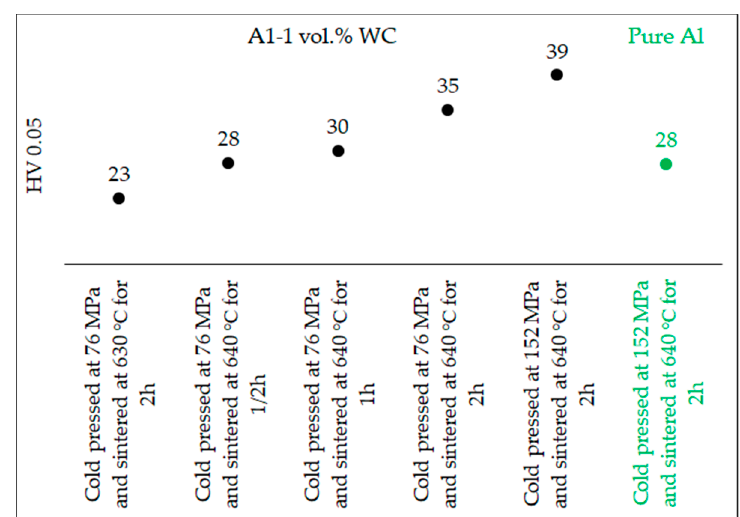
Figure 7. Microhardness values as a function of processing conditions for the Al-WC composite and the non-reinforced Al.